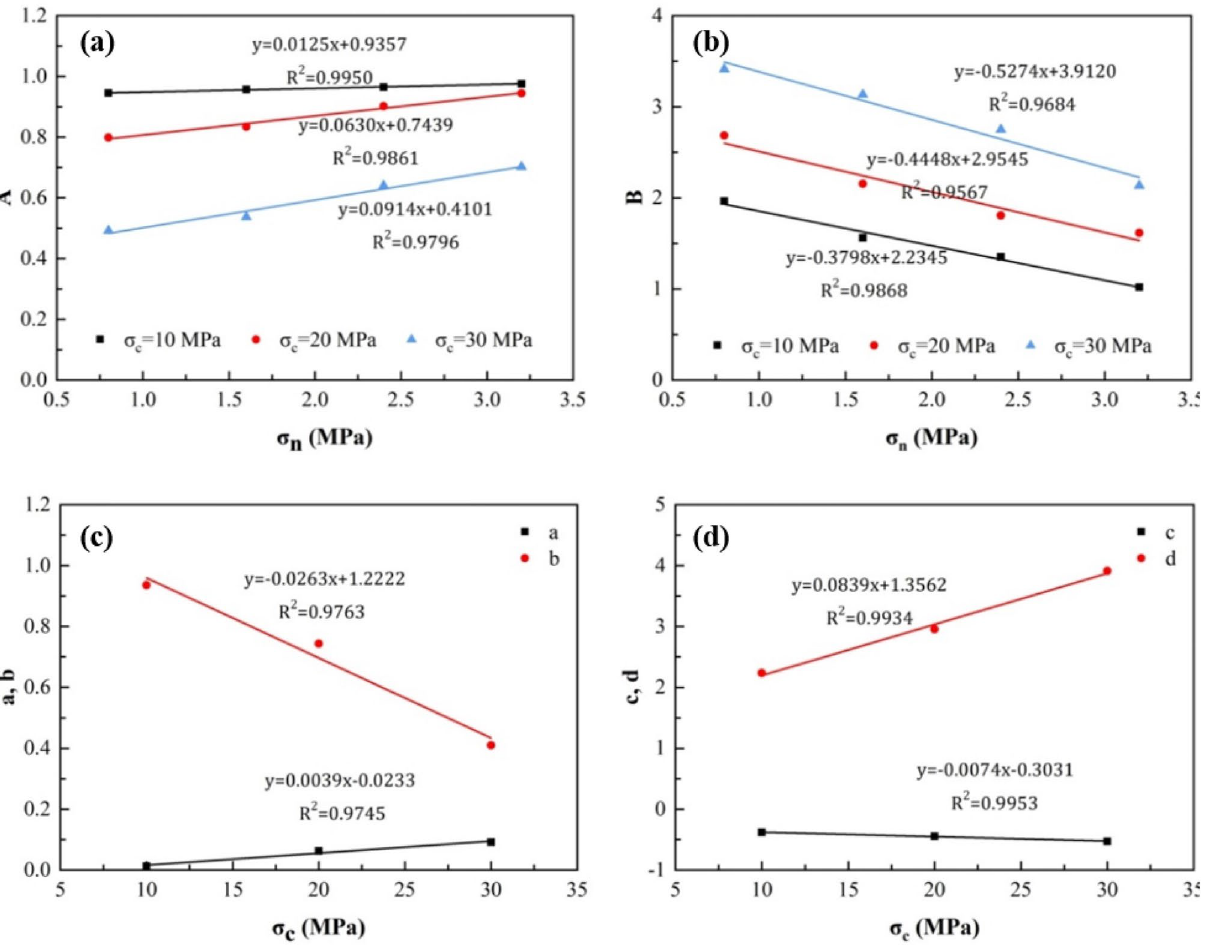
Figure 6. Relationship curves between parameters. ( a ) Relationship curves between parameter A and σ n ; ( b ) relationship curves between parameter B and σ n ; ( c ) relationship curves between parameter a, b and σ c ; and ( d ) relationship curves between parameter c,d and σ c